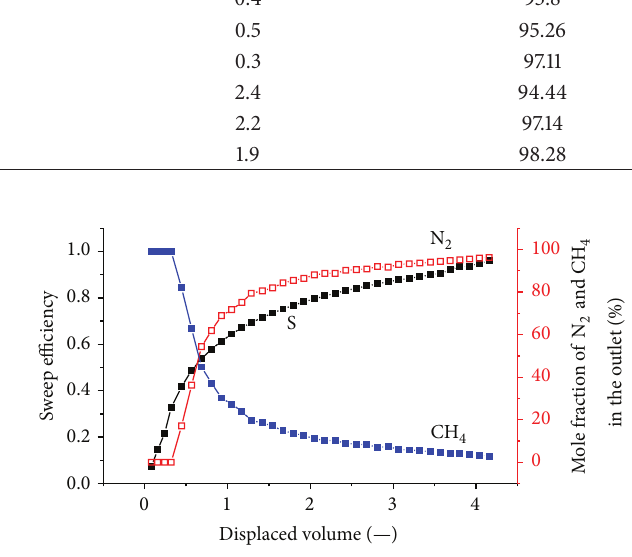
Figure 7: The sweep efficiency and concentrations of produced gas against displaced volume at 2.2 MPa.